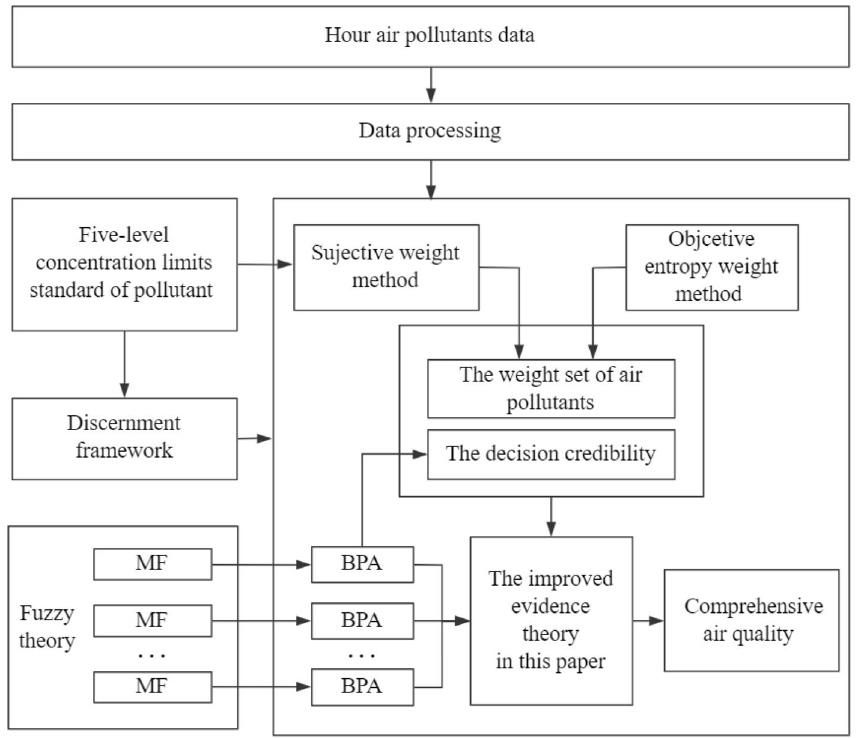
Figure 1. Air quality evaluation model based on improved evidence theory.